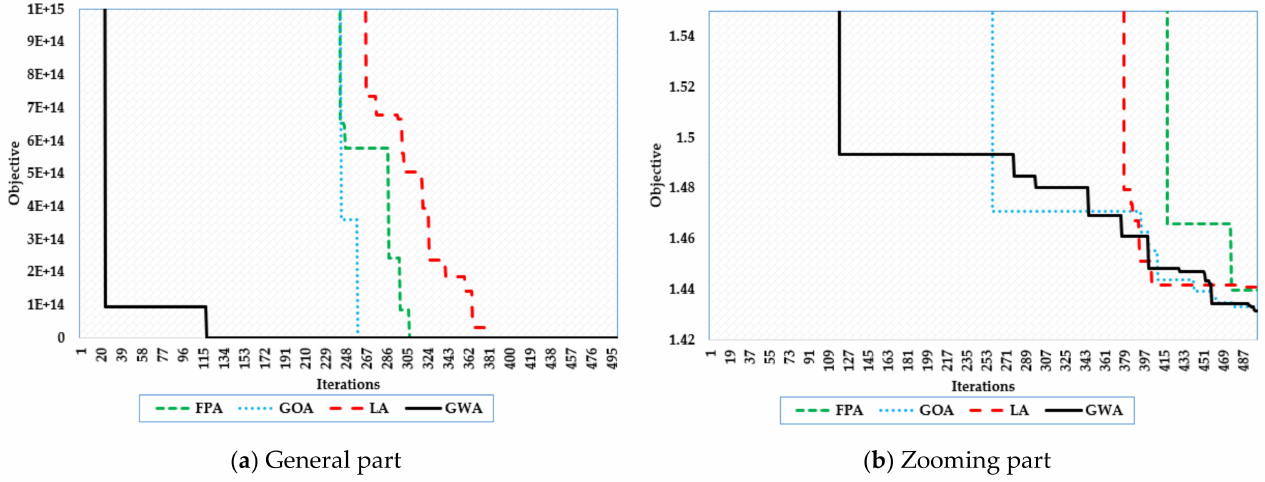
Figure 6. Best Convergence curves of GWA, FPA, LA, and GOA for TLSM design under first